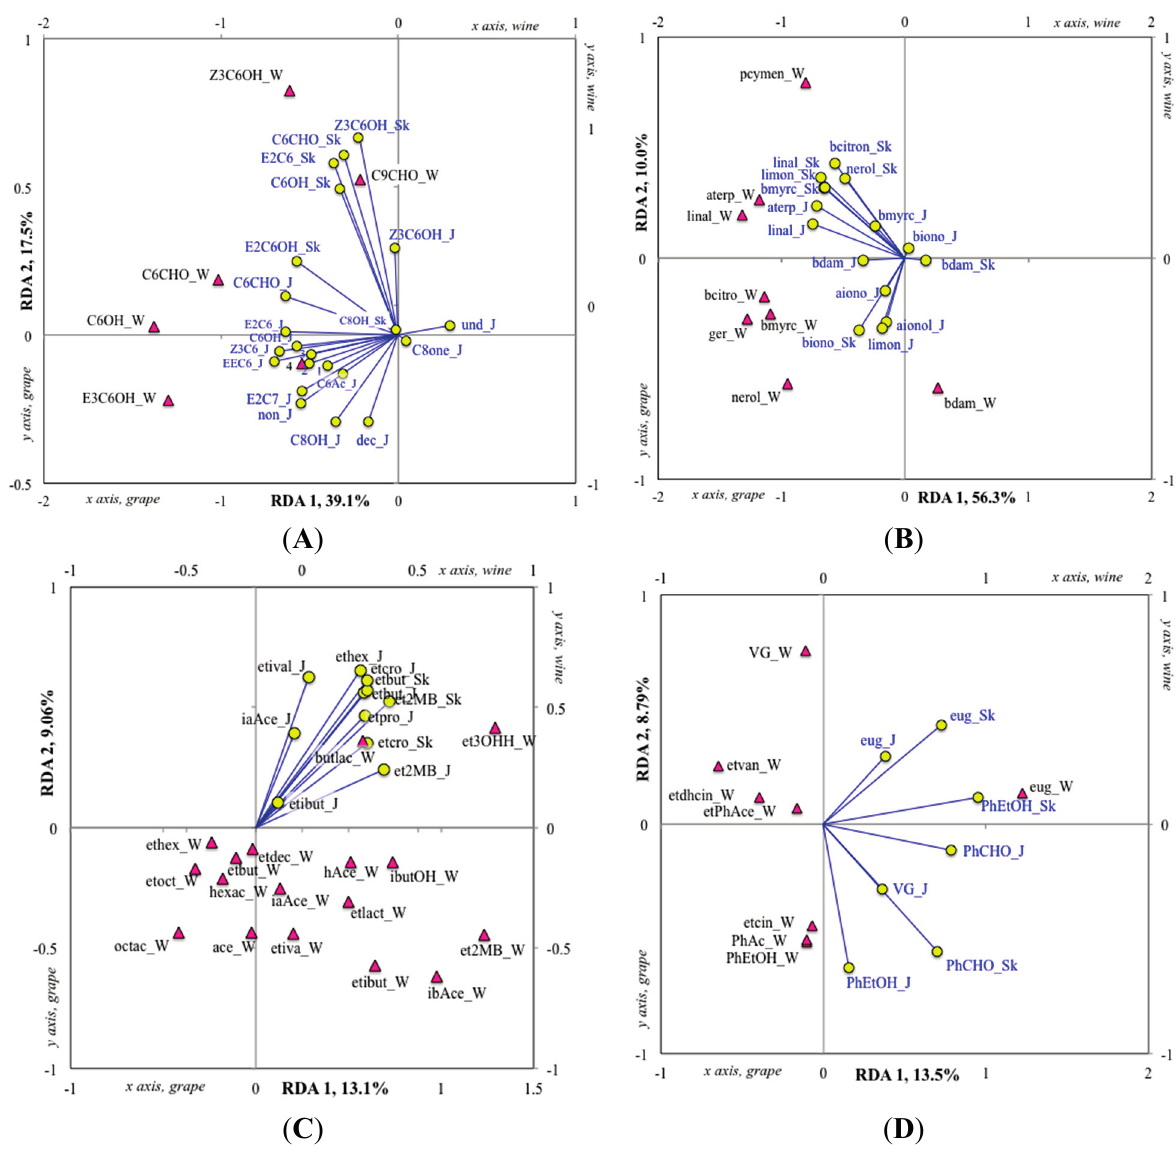
Figure 2. Biplots of four redundancy analyses relating berry volatile compounds (juice and berry skin, independent variables, yellow circles) to wine volatile compounds (dependant variables, red triangles) in the interspecific hybrid grape varieties Frontenac, Marquette, Maréchal Foch, Sabrevois and St. Croix ( n = 32), for the following groups of compounds: Fatty acid degradation products ( A ), Terpenes and C 13 -norisoprenoids ( B ); Non-aromatic acids, esters, alcohol and acetates ( C ); and Aromatics ( D ). The variables are identified as follow: ( A ) Berry juice (_J) and skin variables (_Sk): hexanal (C6CHO_J; C6CHO_Sk), ( Z )-3-hexenal (Z3C6_J), ( E )-2-hexenal (E2C6_J; E2C6_Sk), 2-octanone (C8one_J), ( E )-2-heptenal (E2C7_J), hexanol (C6OH_J; C6OH_Sk), ( Z )-3-hexenol